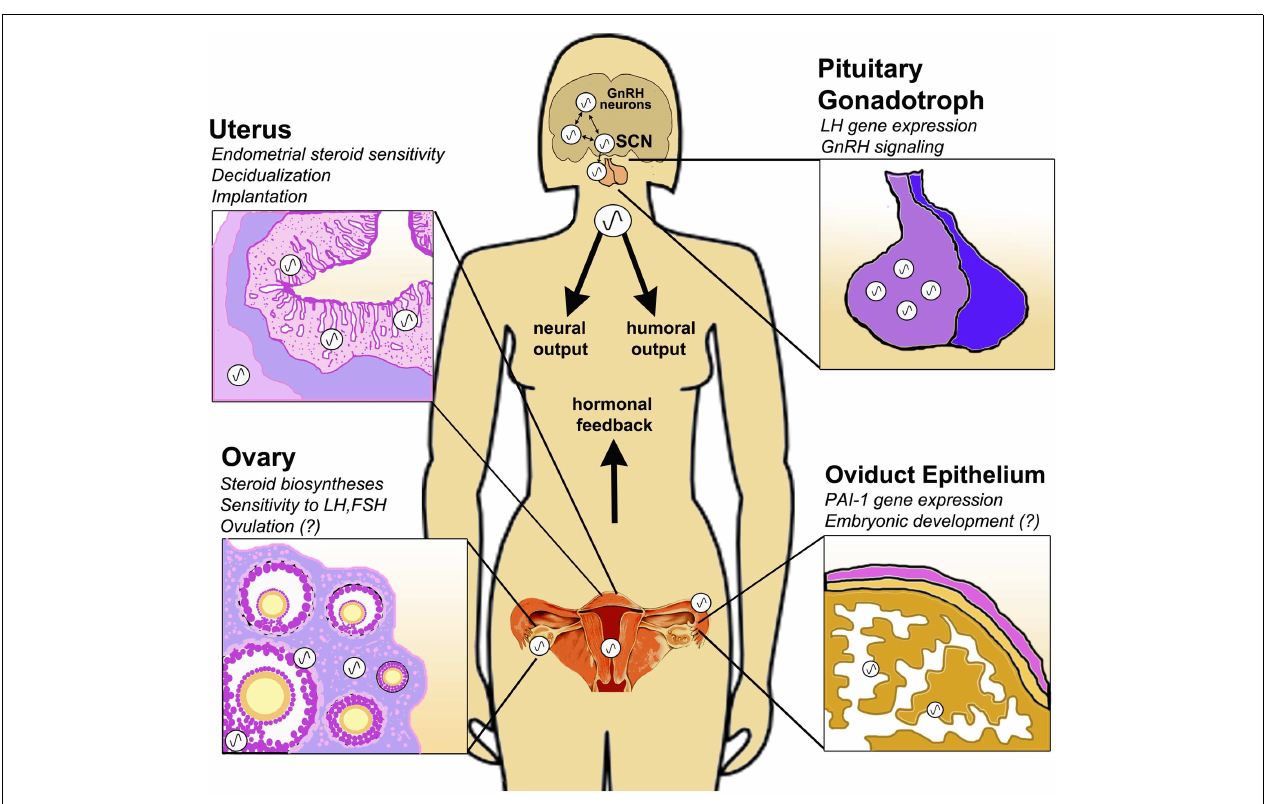
been implicated in GnRH signaling, gonadotropin sensitivity, ovulation, steroid hormone synthesis, embryonic maturation, implantation, and decidualization. Synchronization of central and peripheral oscillators is mediated by several putative humoral and neural cues, driven either directly or indirectly by the SCN. Moreover, feedback signals from the periphery, e.g., steroid hormones of ovarian origin, modulate the timing of the clock in both central and peripheral tissues of the HPG